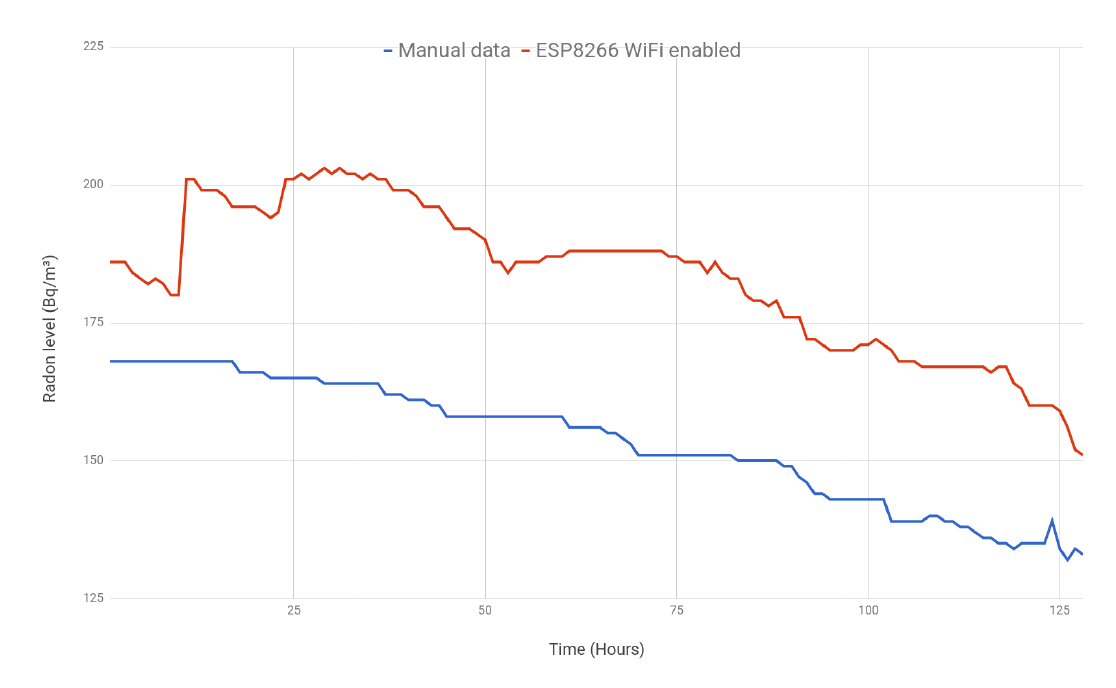
Figure 14. Manual data (without ESP) vs. ESP with WiFi